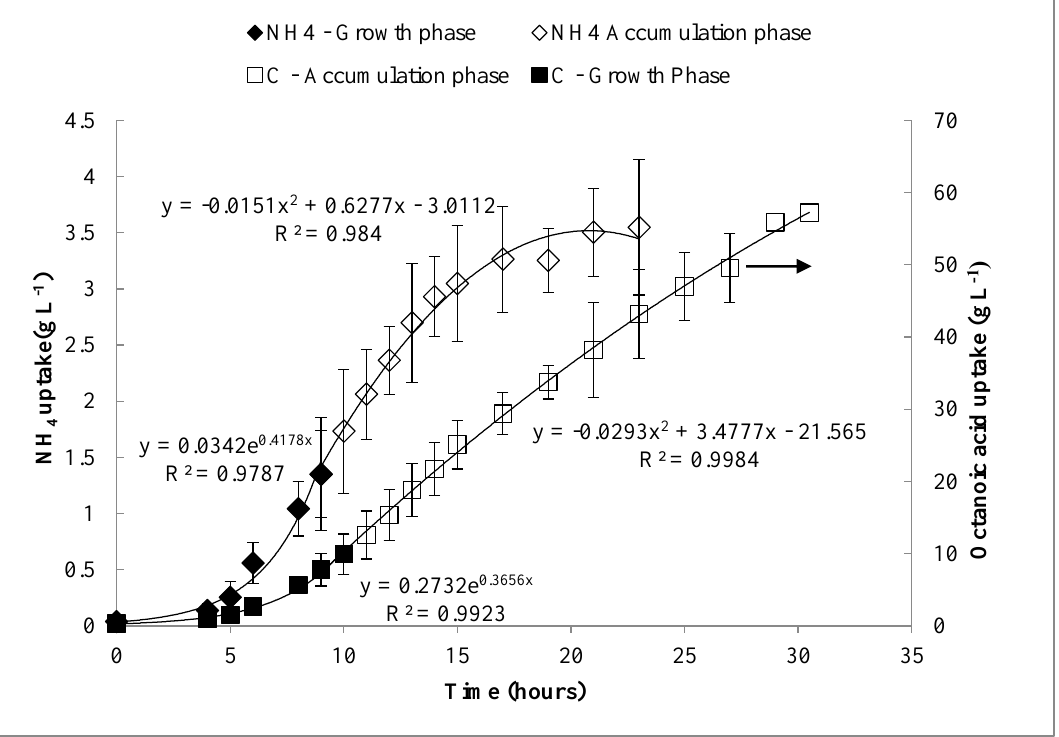
Figure 3. Modeled cumulative feeding of carbon and ammonium over the time course of the pulse feed experiments. Error bars represent standard deviations between three biological replicates.